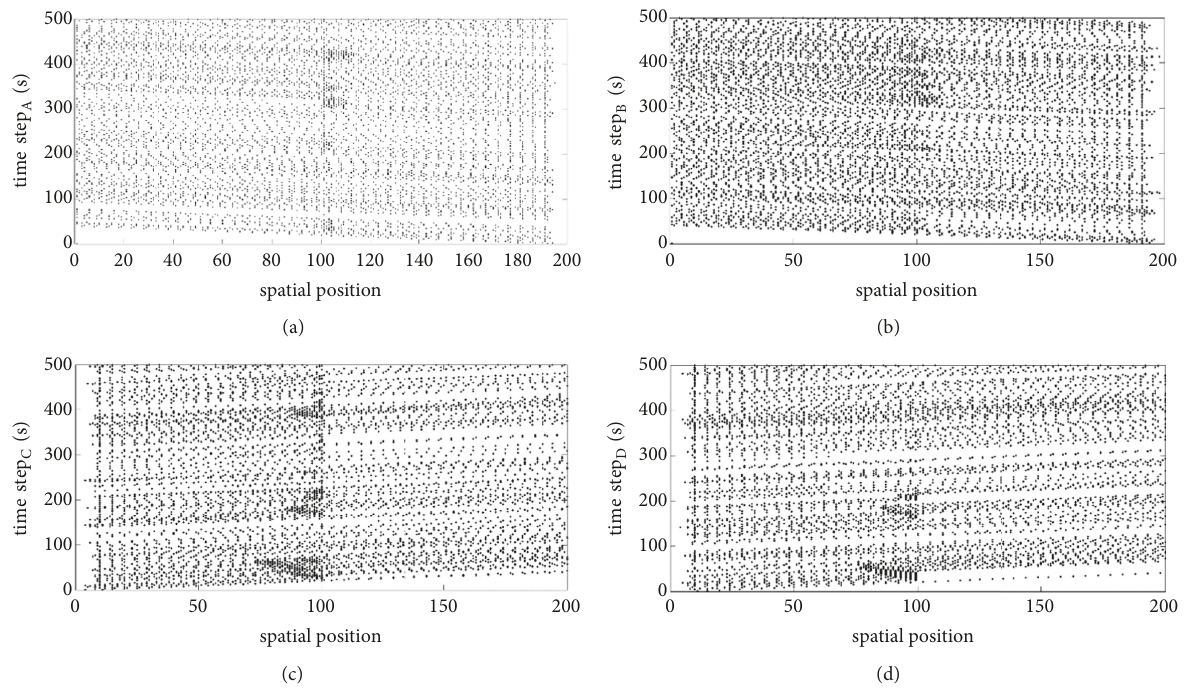
Figure 10: Space-time diagram in lane when 𝑝 𝑖𝑛1 = 0.3 𝑝 𝑖𝑛2 = 0.3 ; and 𝑝 𝑢𝑡𝑢𝑟𝑛 = 0.2 . (a) Lane A, (b) Lane B, (c) Lane C, and (d) Lane